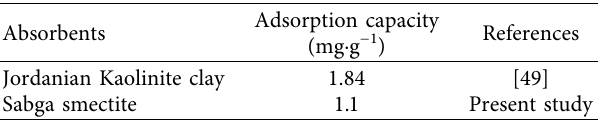
Table 12: Comparison of adsorption capacity of lead (II) ions